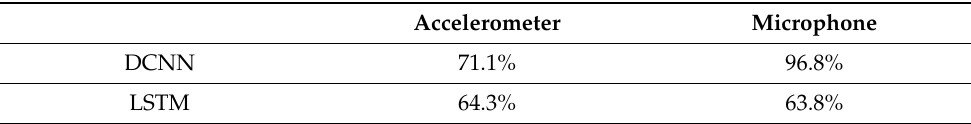
Figure 10. The LSTM models inferences in terms of recall and precision. ( a ) Recall. ( b ) Precision. Table 2. Accuracy of models trained with single sensor